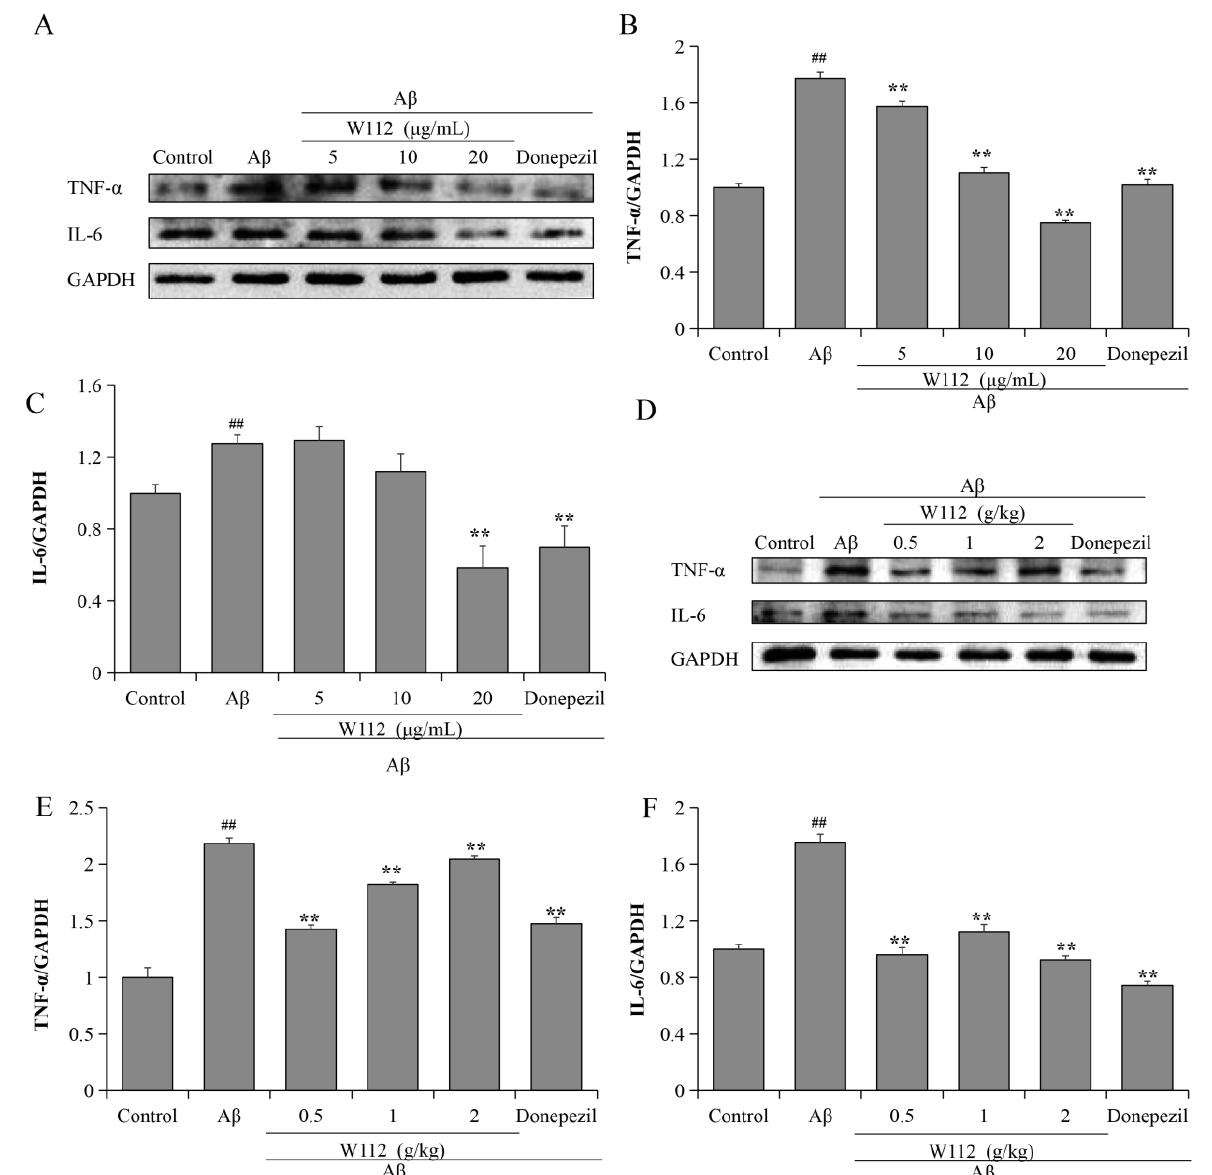
Figure 5. W112 suppressed the production of proinflammatory cytokines TNF- α and IL -6 in Aβ 25 – 35 -induced cell and rat models. ( A – C ) The expressions of TNF- α and IL -6 in PC12 cells were measured by Western blot. n = 3. ( D – F ) The expressions of TNF- α and IL -6 in the hippocampus were measured by Western blot. n = 8. ## p < 0.01 vs. the control group; ** p < 0.01 vs. the model group.